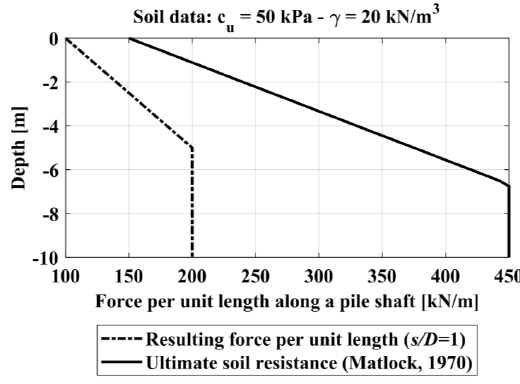
Figure 8. Resulting soil pressure profile.